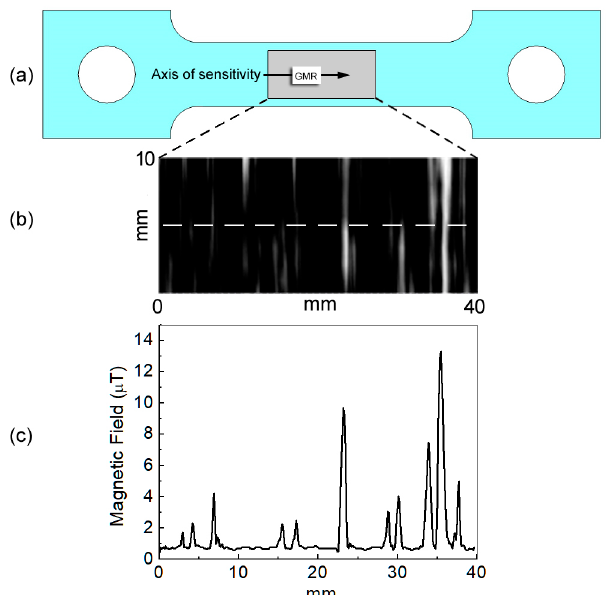
Figure 11. ( a ) Drawing of the sample where the rectangular grey area represents the area where the GMR gradiometer imaging has been obtained. ( b ) GMR imaging of the sample surface, the white stripes are due to plastic deformation (slip bands). ( c ) Magnetic field measured along the white dashed line reported in (b).